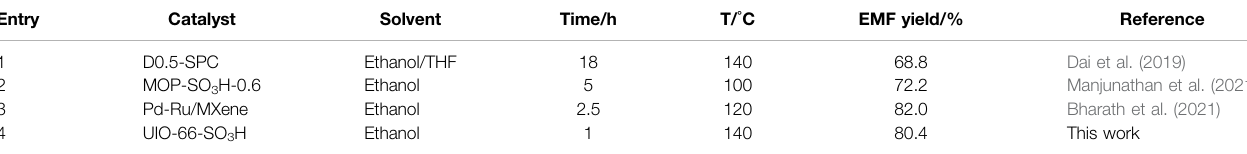
TABLE 2 | Catalytic performance of UIO-66-SO 3 H compared to reported solid acid catalysts for the EMF synthesis from